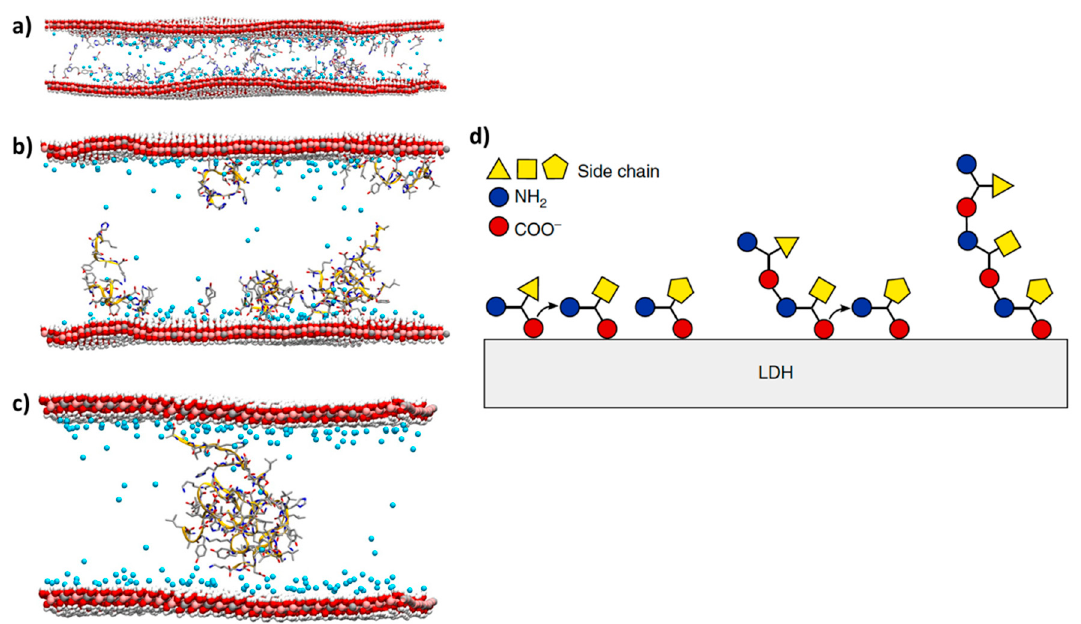
Figure 5. Amino acids on LDHs. Ensembles of ( a ) amino acids; ( b ) short; and ( c ) long peptides intercalated into LDH interlayers via their C-terminal. ( d ) Proposed mechanism for peptide bond formation inside LDH interlayers. Reproduced from Ref. [54] under the terms of the Creative Commons CC BY license.